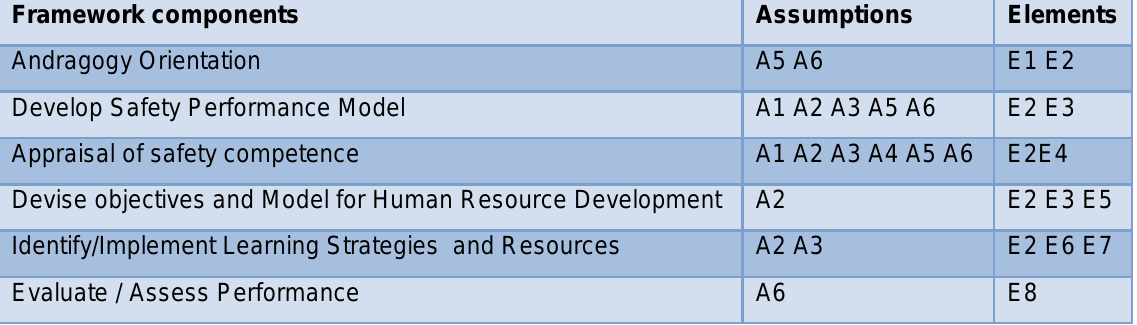
Table 3 Incorporation of andragogy assumptions and process